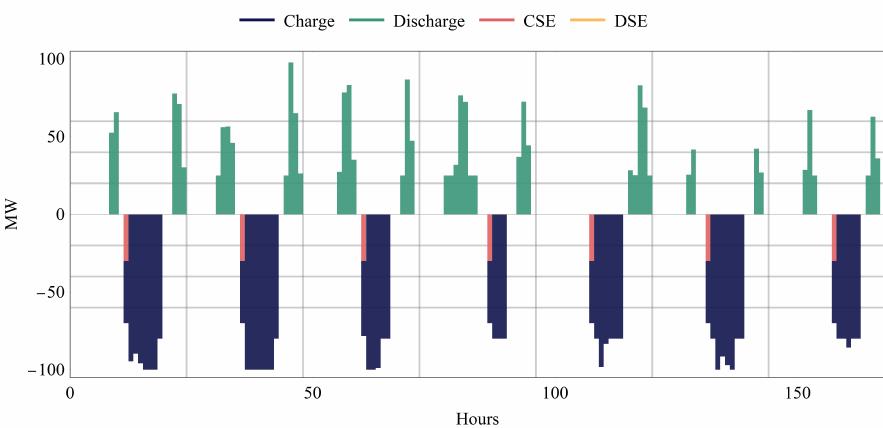
Figure 9. LAES charging-discharging, sample week of summer 2030, proposed model.